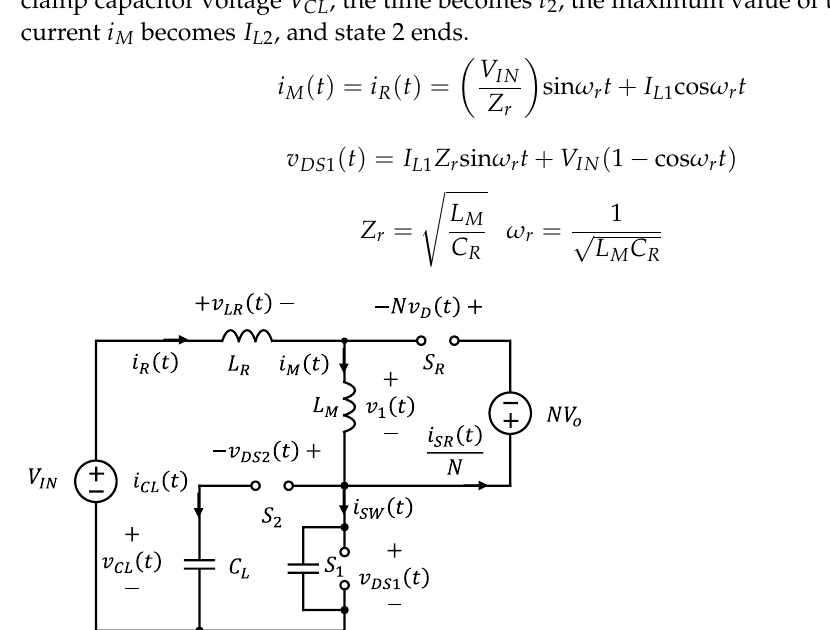
Figure 7. Equivalent circuit in state 2.